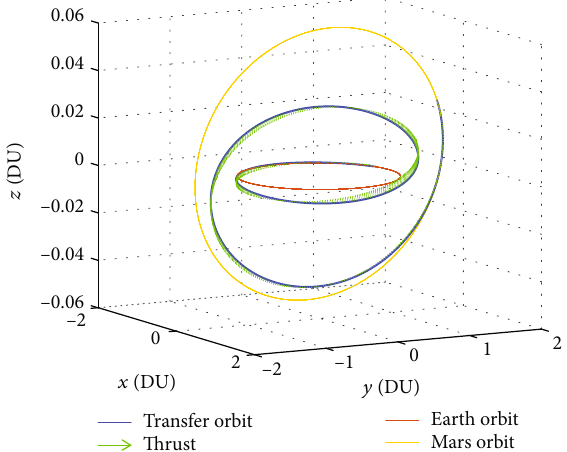
Figure 5: Earth-Mars rendezvous trajectory with the least amount of fuel.